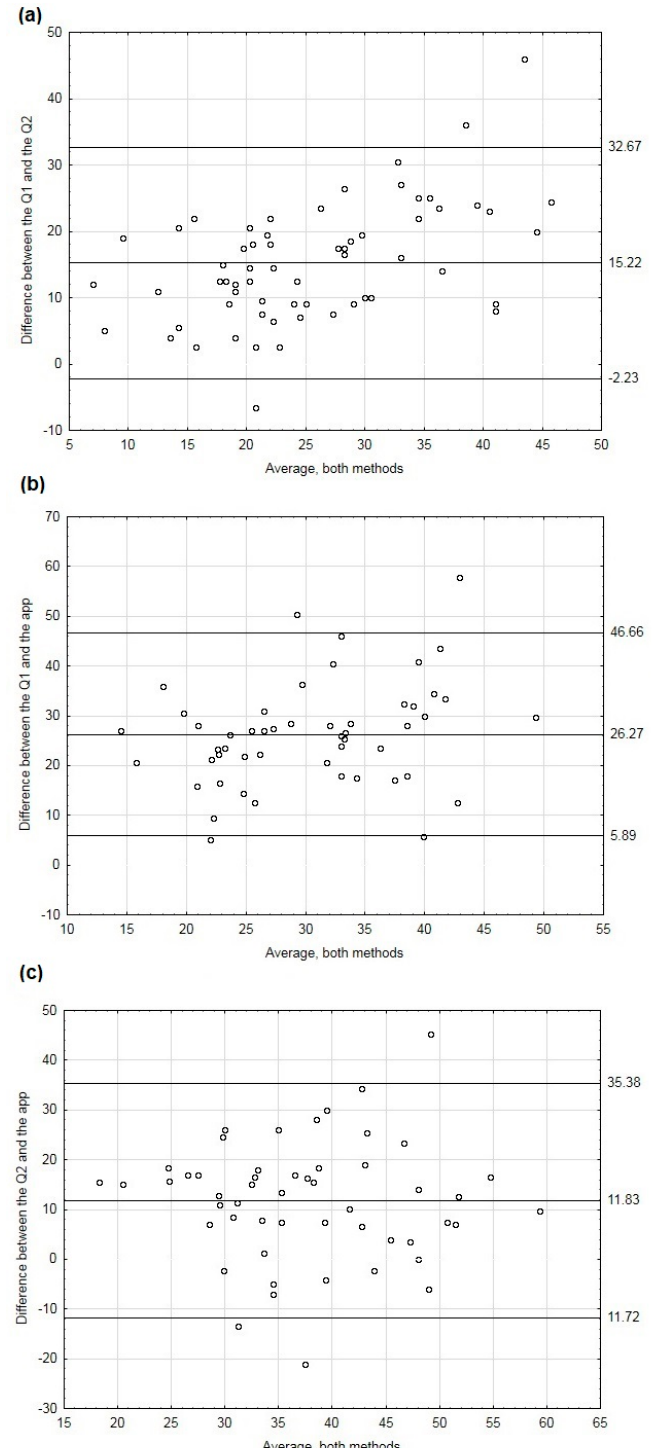
Figure 1. Bland–Altman plots of individual differences between Q1 and Q2 ( a ), Q1 and the app ( b ) and Q2 and the app ( c ). In case of the app, only data from valid responses were considered. Valid responses were those in which respondents gave replies to at least three prompts on at least five days.